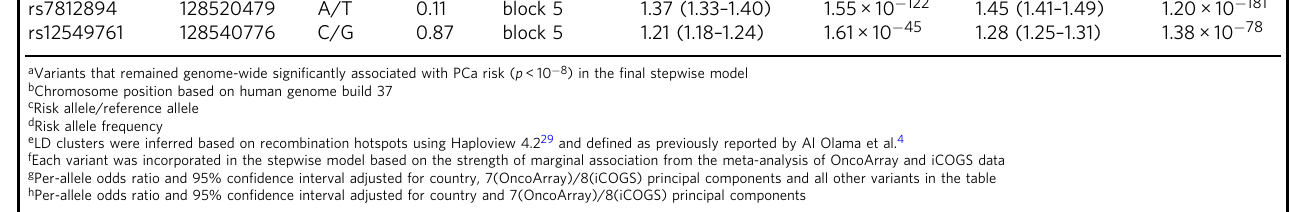
c Risk allele/reference allele d Risk allele frequency e LD clusters were inferred based on recombination hotspots using Haploview 4.2 29 and de fi ned as previously reported by Al Olama et al. 4 f Each variant was incorporated in the stepwise model based on the strength of marginal association from the meta-analysis of OncoArray and iCOGS data g Per-allele odds ratio and 95% con fi dence interval adjusted for country, 7(OncoArray)/8(iCOGS) principal components and all other variants in the table h Per-allele odds ratio and 95% con fi dence interval adjusted for country and 7(OncoArray)/8(iCOGS) principal